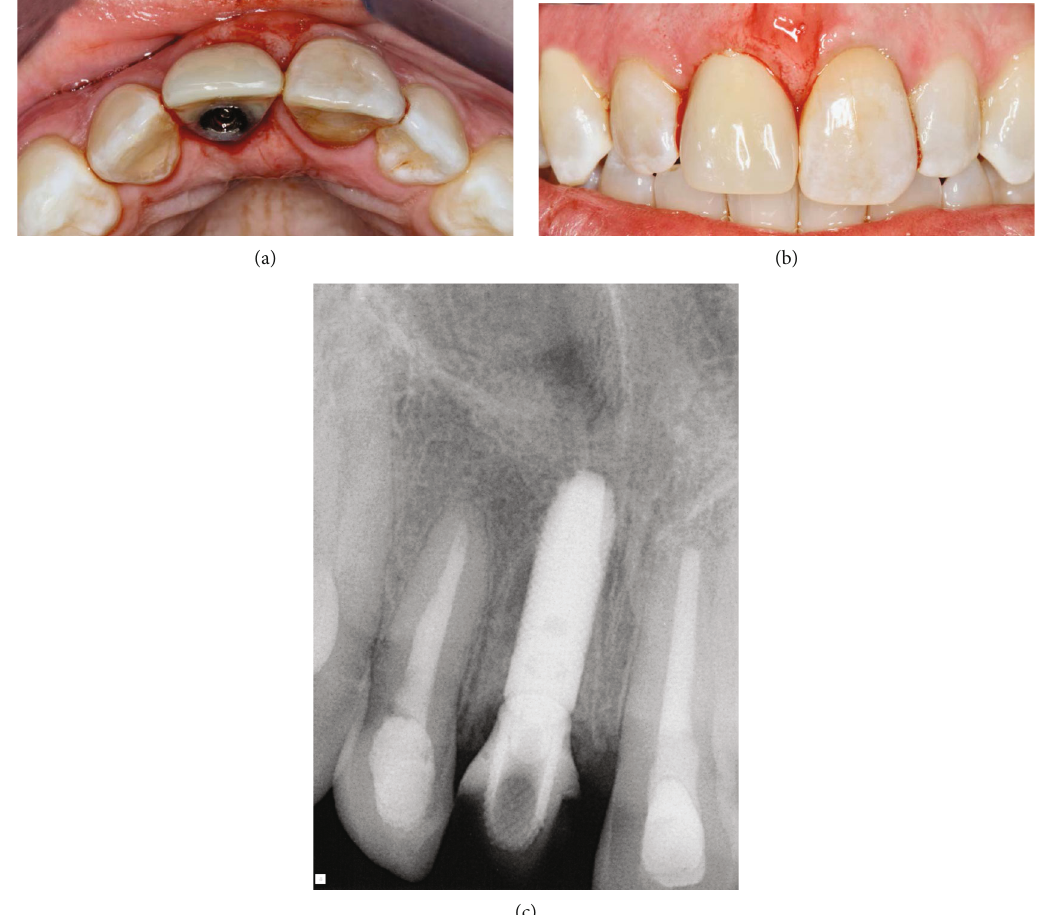
Figure 5: A customized screw-retained provisional crown was made chairside immediately after implant placement. (a) Occlusal view of the provisional crown showing the location of the implant at the cingulum region. (b) Facial view of the provisional crown displaying its subgingival contour conformed to support the soft tissue emergence pro fi le. (c) A periapical radiograph was taken immediately after provisional crown